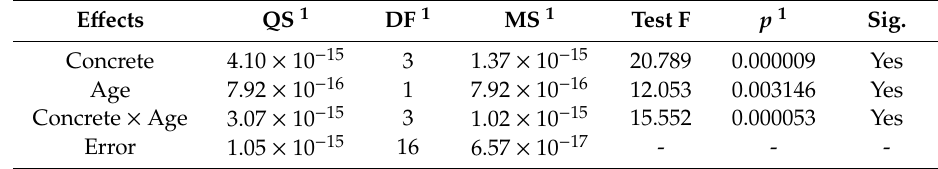
Table 9. Analysis of variance (ANOVA) of the diffusion coefficients.